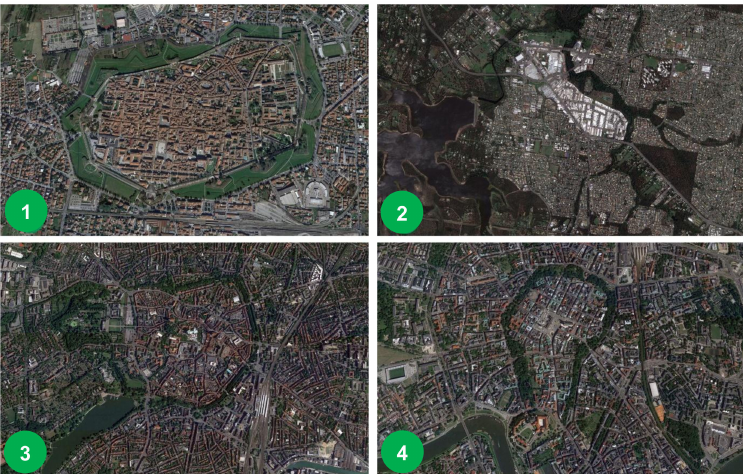
Figure 6. Examples of urban green belt biosphere reserves: ( 1 ) Lucca, Italy; ( 2 ) Capalaba, Australia; ( 3 ) Munster, Germany; ( 4 ) Cracow’s Old Town, Poland (Source: aerial views from Google